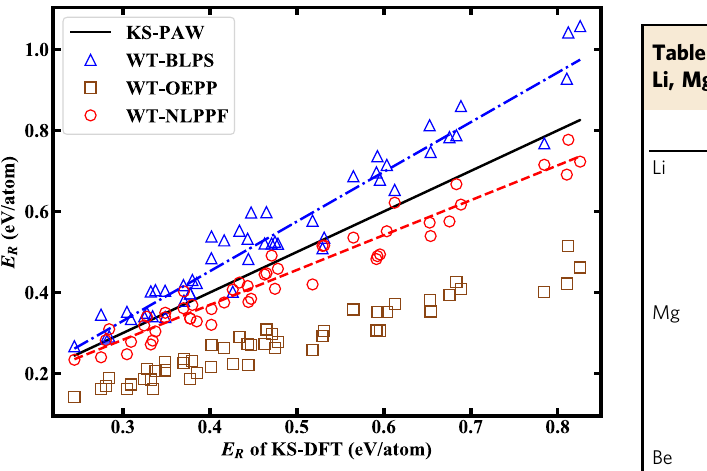
Fig. 2 Relative energies for random structures of elemental Li. The results are calculated by OF-DFT using BLPS, OEPP and NLPPF in comparison with that by KS-DFT using the PAW method. Blue dash-dotted and red dashed lines are the least-square fi ttings of WT-BLPS and WT-NLPPF results, respectively.